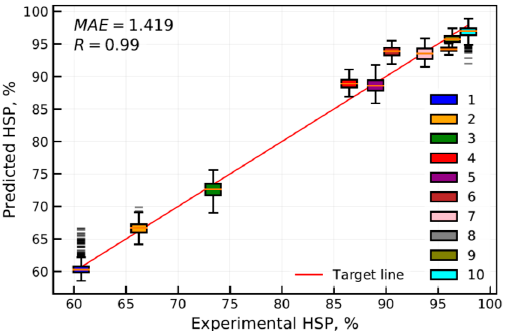
Figure 6. Correlation between the experimental and predicted HSP at test dataset. Box plot numbers are associated with the studied steel grades according to Table 1.